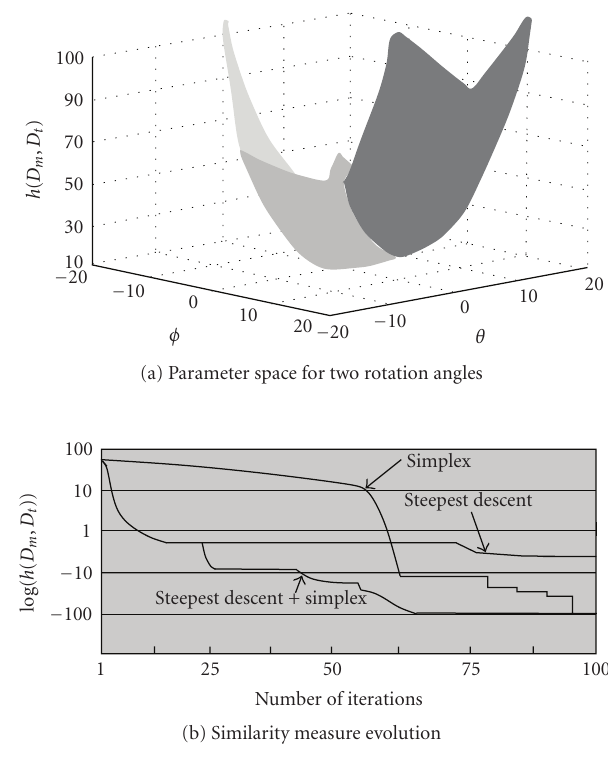
Figure 4: Appropriateness of the dHd. (a) Feature space for two ro- tation angles given in degrees. The D m (3D sensor data) and D t (CT modality) point sets were acquired for a phantom (plaster head). The h ( D m , D t ) surface is not only convex for these two angles, but also for all other parameters of the isometry. (b) Similarity measure evolution. The decimal logarithm values of h ( D m , D t ) are given for each iteration of the optimization. The combination of the steepest gradient and the simplex allows both a fast and accurate conver-